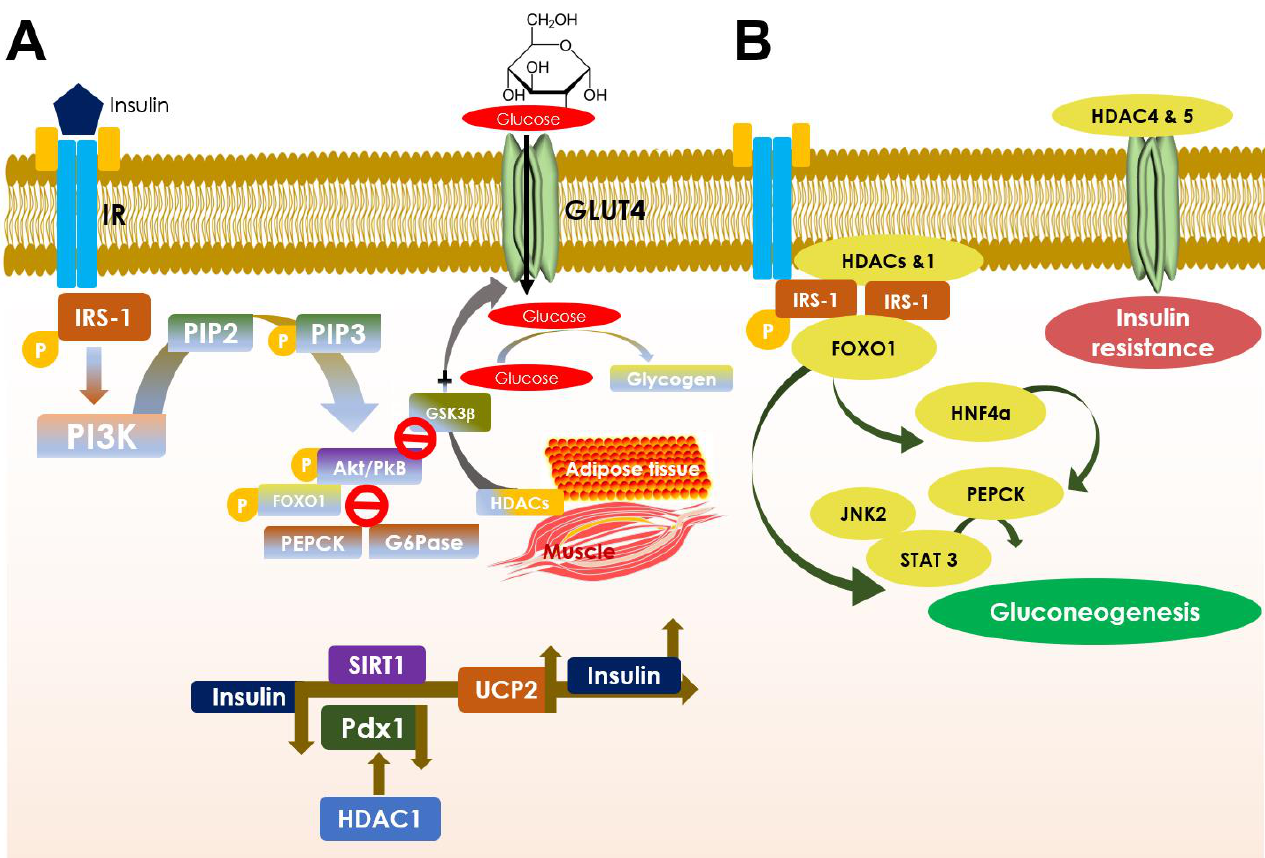
Figure 3. Schematic diagram showing the role of HDACs in glucose homeostasis ( A ) and in developing insulin resistance ( B ). A. Insulin binding at insulin receptor (IR) stimulates IRS-1 substrate phosphorylation and PI3K binding at it that